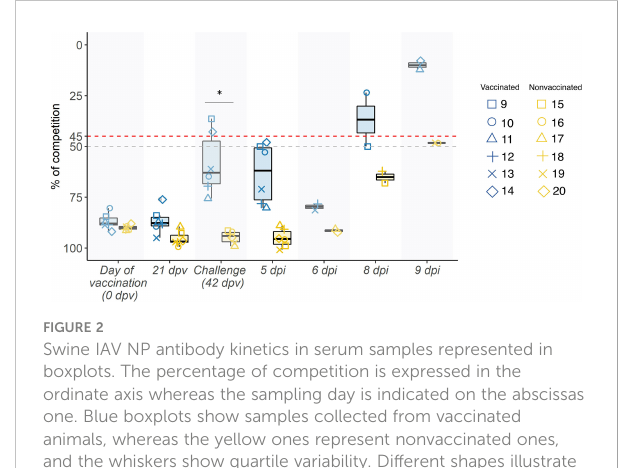
FIGURE 2 Swine IAV NP antibody kinetics in serum samples represented in boxplots. The percentage of competition is expressed in the ordinate axis whereas the sampling day is indicated on the abscissas one. Blue boxplots show samples collected from vaccinated animals, whereas the yellow ones represent nonvaccinated ones, and the whiskers show quartile variability. Different shapes illustrate the ID number of each pig. Values above the red line (<45%), below the grey line (>50%) and between both lines are considered positive, negative, and doubtful respectively. * P < 0.05